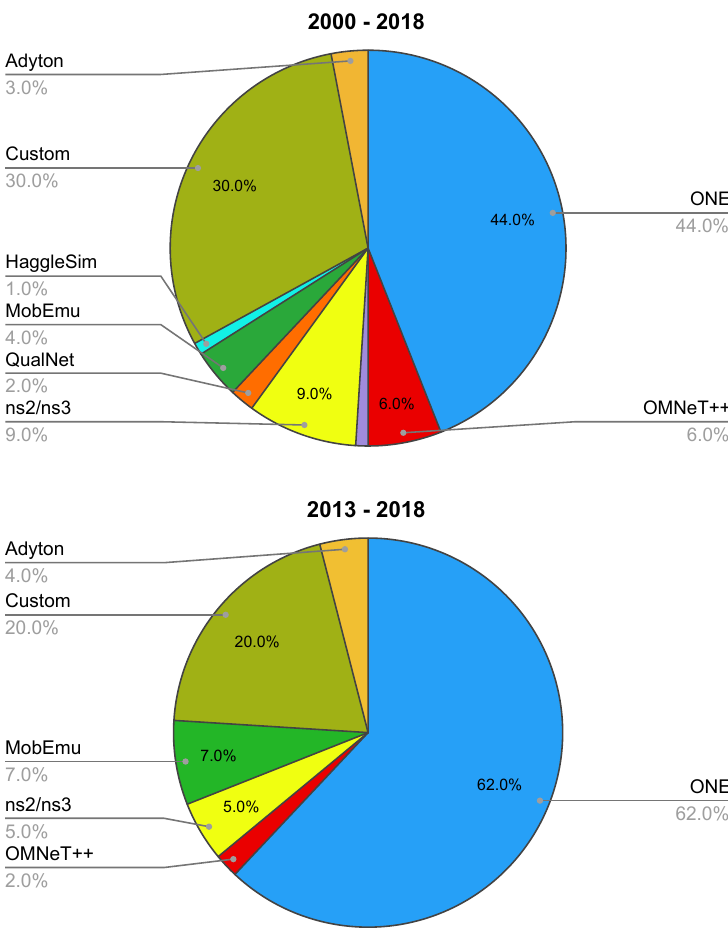
Figure 2. Used evaluation environments: for all surveyed publications ( top ); and for all recent studies since 2013 ( bottom